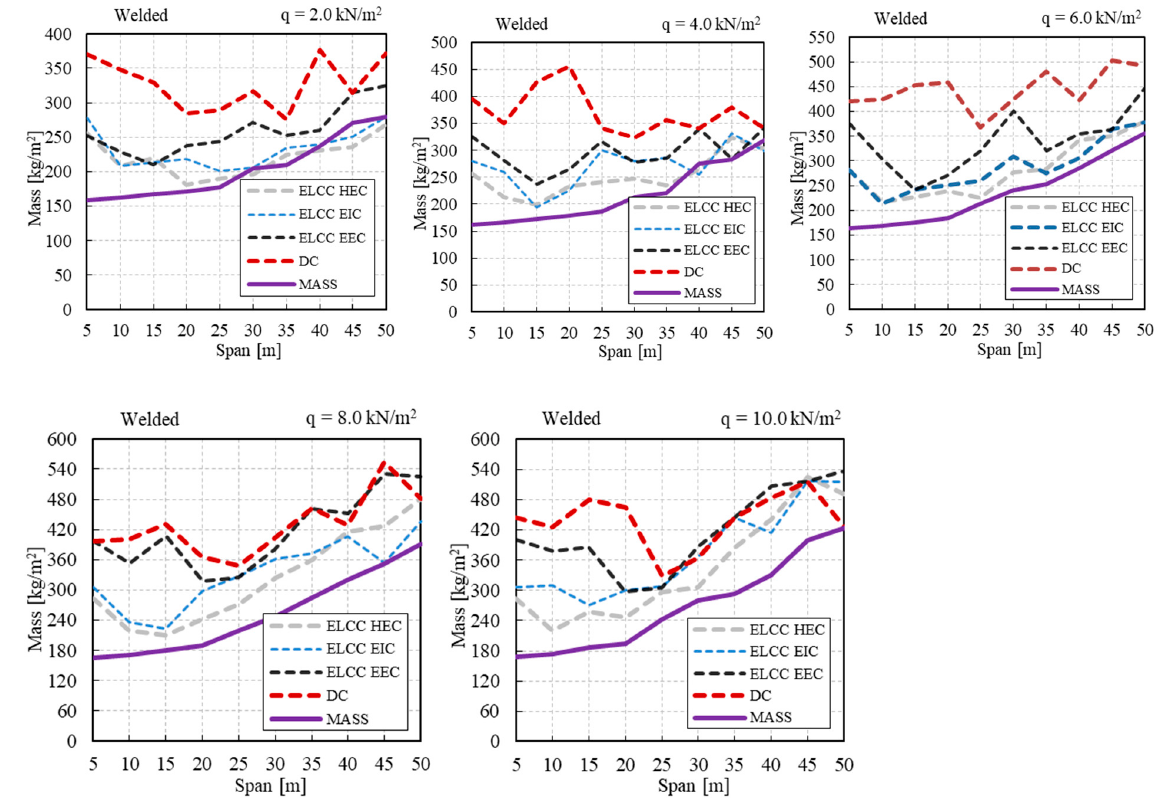
Figure 13. Diagrams of the calculated masses of the CFSWIS structures for different objective functions.